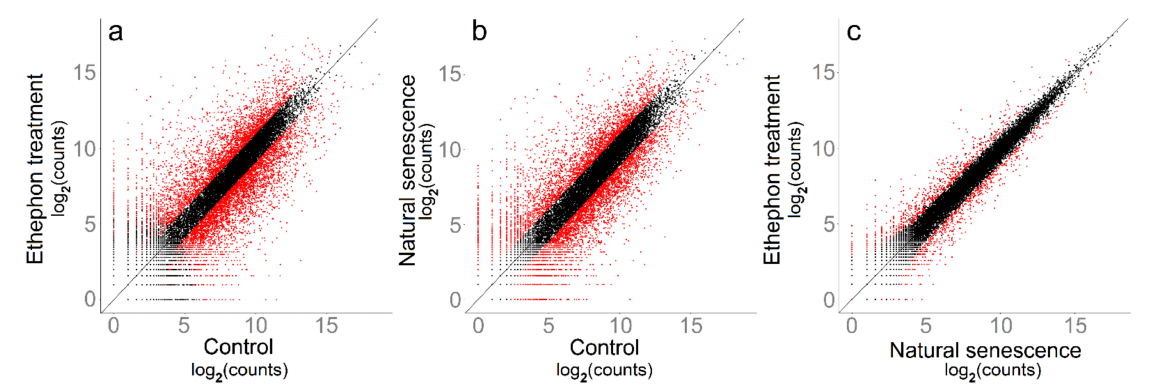
Figure 2. Scatter plots of log 2 -normalized mean gene counts of control vs. ethephon treatment ( a ), control vs. natural senescence ( b ) and natural senescence vs. ethephon treatment ( c ). Differentially transcribed genes (DTGs) of each pairwise comparison are marked red.